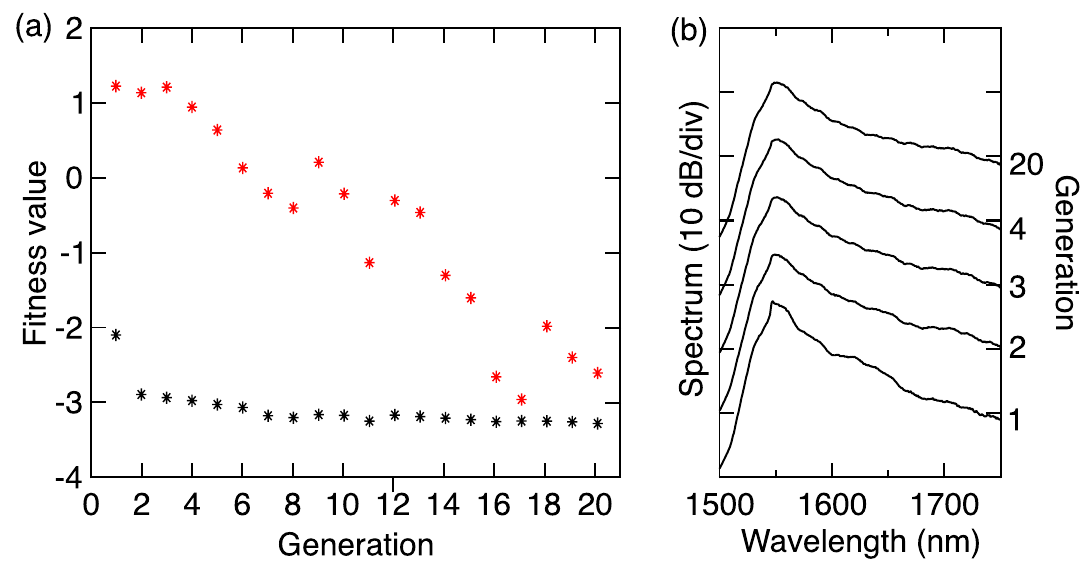
Figure 5. ( a ) Evolution of the objective function over 20 generations of the genetic algorithm. At each generation, we show the mean of the population (red stars) and the particular individuals corresponding to the minimum fitness values (black stars). ( b ) For the data in ( a ) we show the spectrum of the best individual for the generations as indicated on the right hand